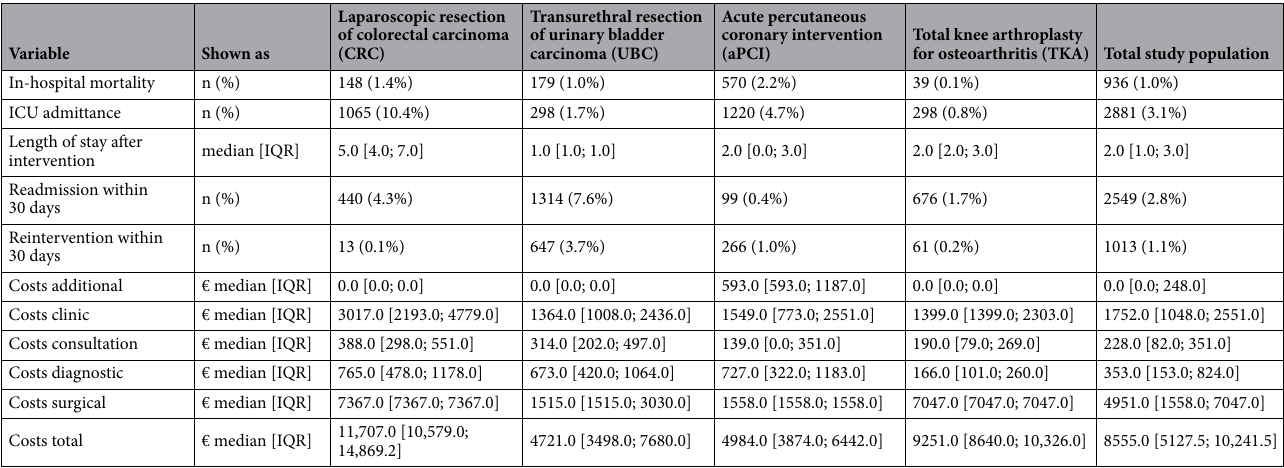
Table 2. Summary statistics of outcomes and costs, by surgical